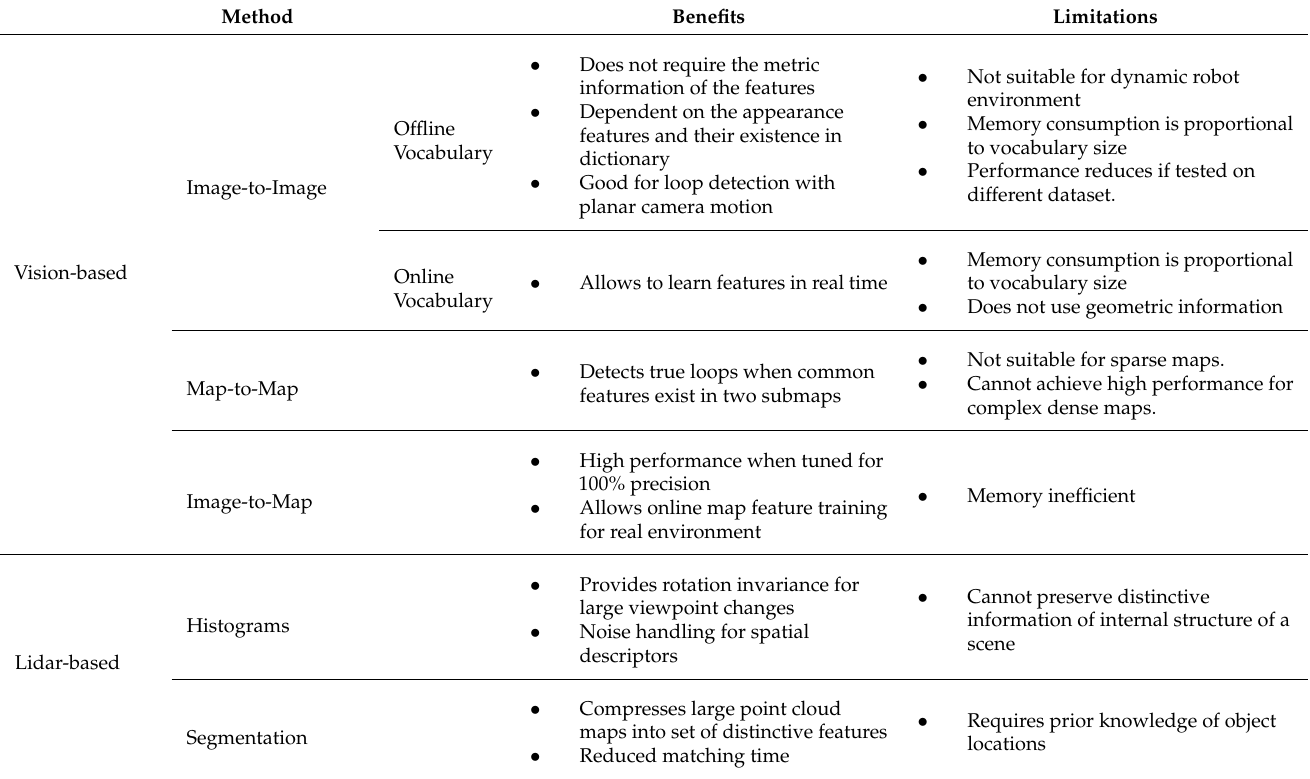
Table 1. Summary of the benefits and limitations of camera and Lidar-based loop closure detection